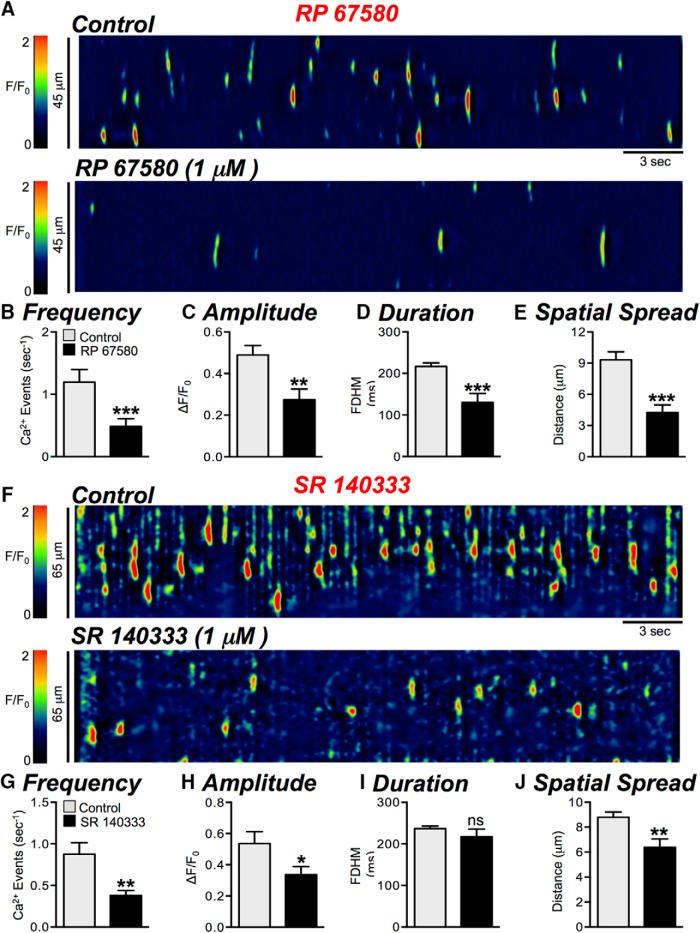
Effects of neurokinin receptor (NK1) antagonists on basal Ca2+ transients. A, Representative ST maps showing the inhibitory effects of the NK1 receptor antagonist, RP 67580 (1 μM), on Ca2+ transients in ICC-DMP. B–E, Summary graphs showing the effects of RP 67580 on the frequency (B), amplitude (C), duration (D), and spatial spread (E) of Ca2+ transients in ICC-DMP (n = 11, c = 27). F, Representative ST maps showing the inhibitory effects of the NK1 receptor antagonist, SR 140333 (1 μM), on Ca2+ transients in ICC-DMP. G–J, Summary graphs showing the effects of 1 μM SR 140333 on the frequency (G), amplitude (H), duration (I), and spatial spread (J) of Ca2+ transients in ICC-DMP (n = 4, c = 14); ns = p > 0.05, *p < 0.05, **p < 0.01, ***p < 0.001.